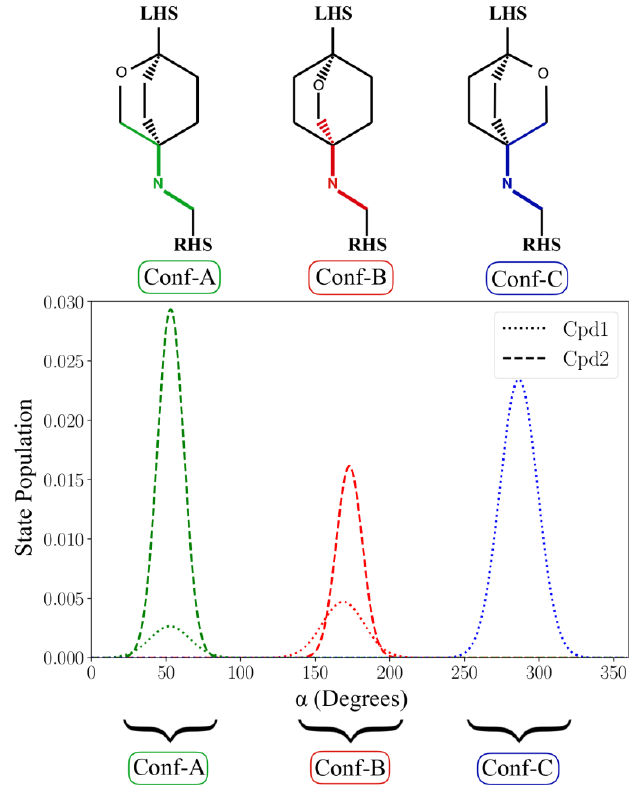
Figure 3 . State population of the value of the α dihedral angle for both Cpd1 and Cpd2 computed over the simulated time. For Cpd1, the α dihedral angle populates the three conformational states, Conf-A, Conf-B, and Conf-C. Cpd2 visits only Conf-A and Conf-B.